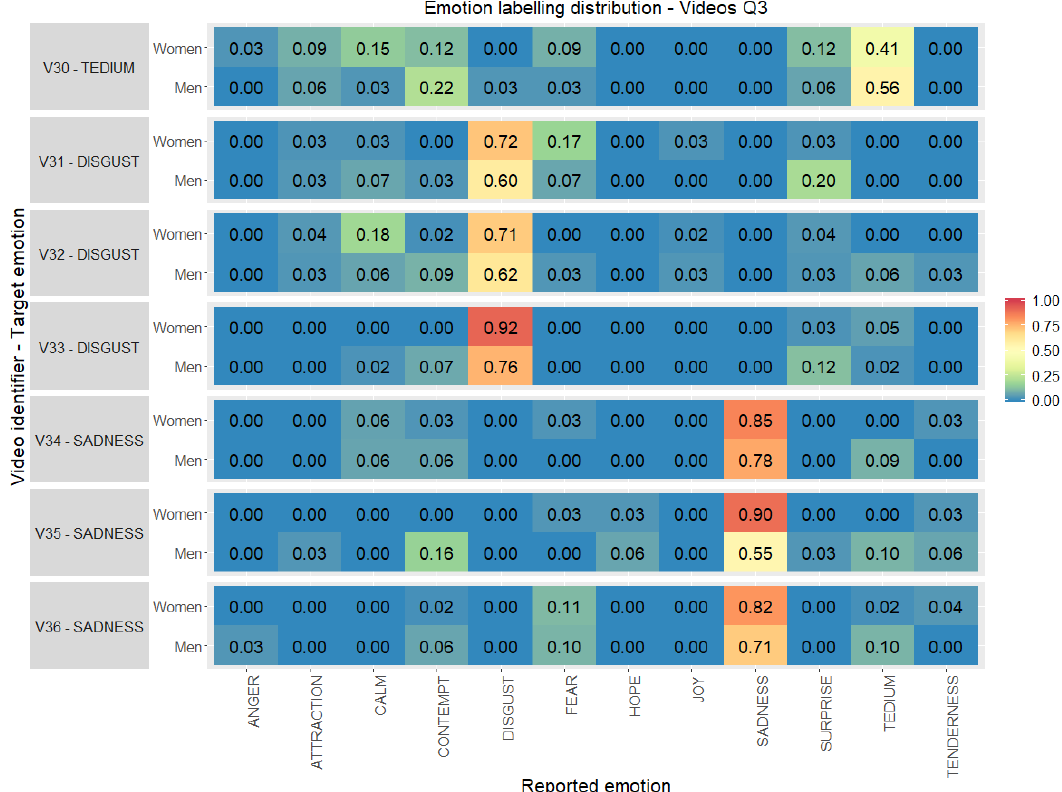
Figure 6. Emotion labelling distribution (0.00–1.00) between the emotions reported by the volunteers with respect to the original target per video clip selected, gender and quadrant 3 (percentage computed considering individually women and men totals per stimuli).